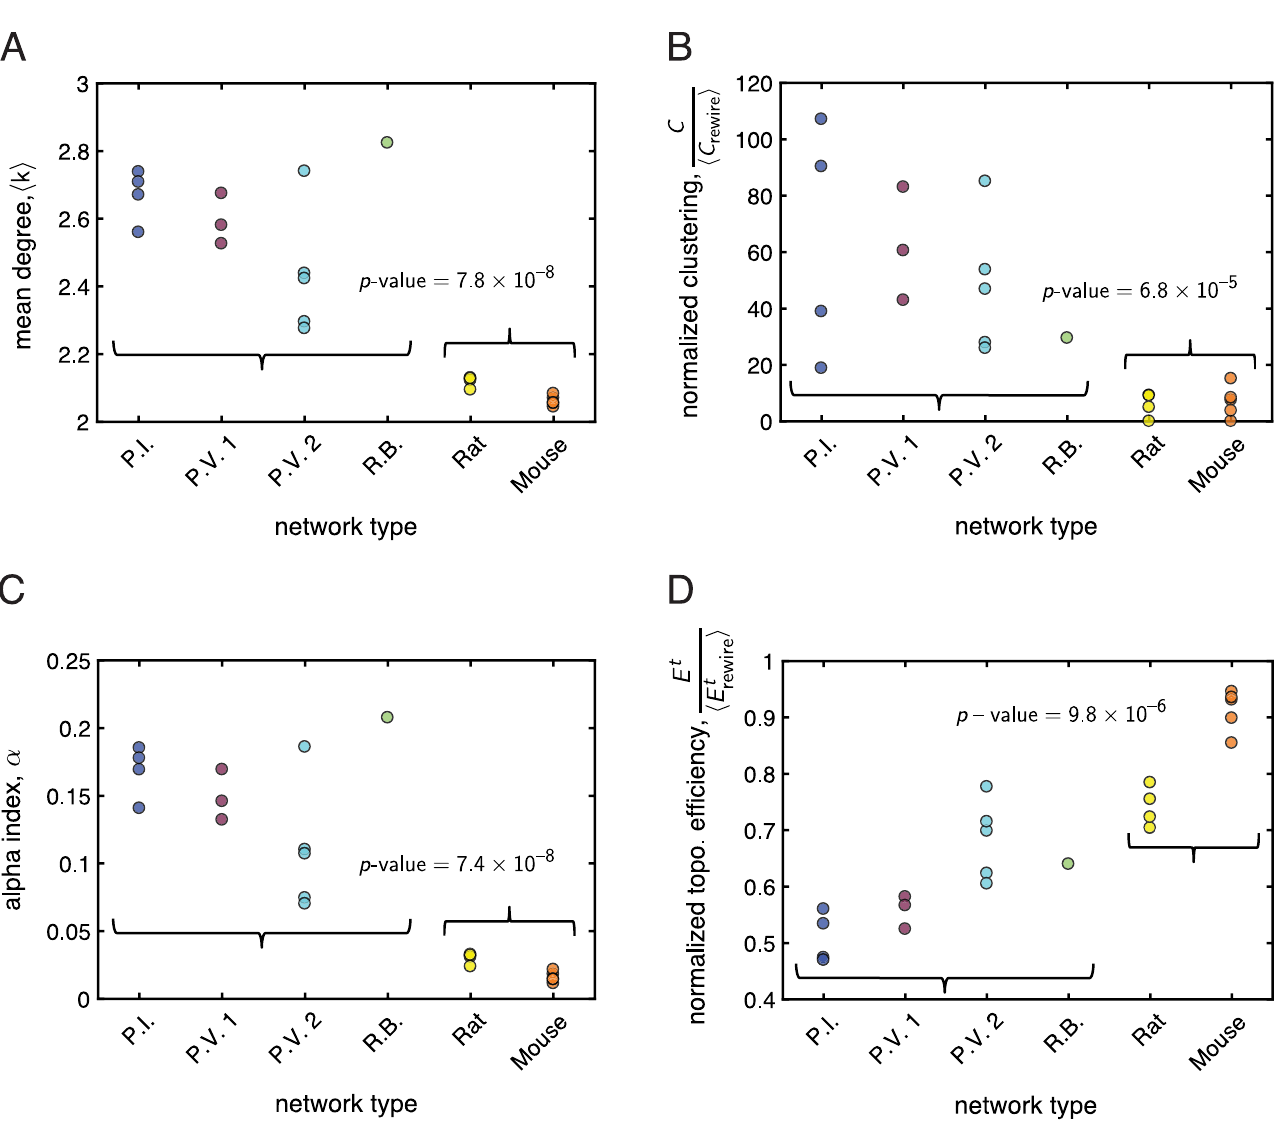
Fig 3. Comparison of topological network metrics between the mycelial and vasculature systems. In each panel, the x -axis labels the kind of network, with the curly braces grouping the mycelia (first 4 networks) and vasculature (last 2 networks). The y -axis measures the value of a given property for each network. A p -value is displayed if we found a statistically significant difference (as determined by a two-sample t -test) in the mean value of the given property between the population of mycelial networks and the population of vasculature networks. (A) The mean degree h k i was significantly larger in the fungi compared to the vasculature. (B) The normalized clustering coefficient C = h C i was significantly larger in the fungi compared to the vasculature. (C) The alpha index α was rewire significantly larger in the fungi compared to the vasculature. (D) The normalized topological efficiency E t = h E t i was significantly larger in the vasculature rewire compared to the fungi. See the main text for more details on each